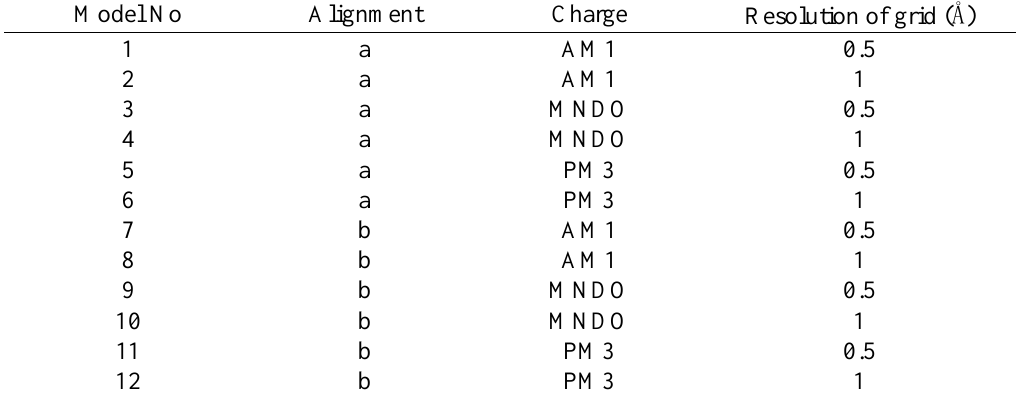
Table 2. Encoding 12 models for the training set used for the SOMFA investigations Model No Alignment Charge Resolution of grid ( Å ) 1 a AM1 0.5 2 a AM1 1 3 a MNDO 0.5 4 a MNDO 1 5 a PM3 0.5 6 a PM3 1 7 b AM1 0.5 8 b AM1 1 9 b MNDO 0.5 10 b MNDO 1 11 b PM3 0.5 12 b PM3